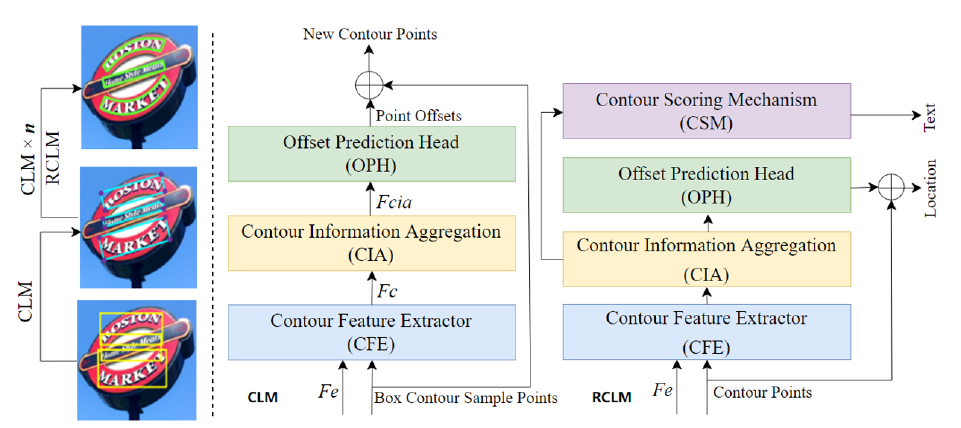
Figure 4. The process of fitting an arbitrarily shaped detection